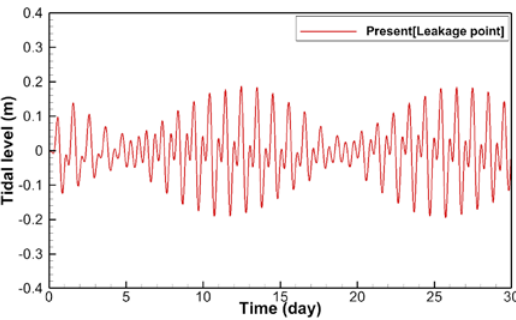
Figure 5. Time history of calculated tidal level in a small-scale domain.